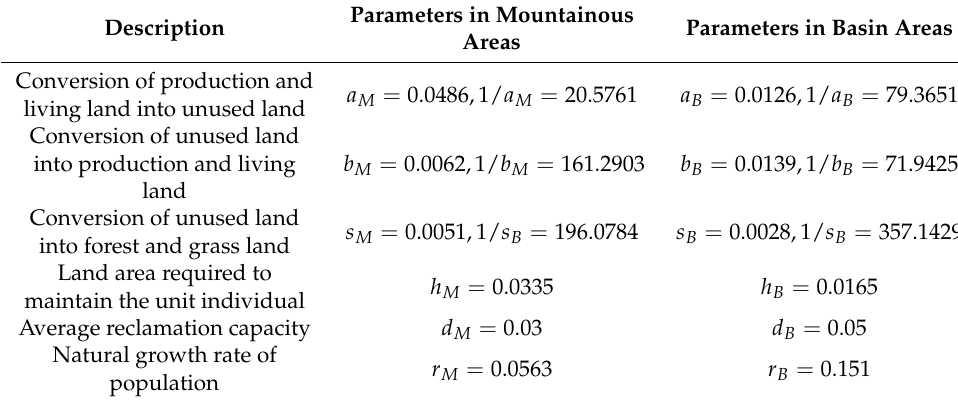
Table 2. Fitting parameters of human–land coupling dynamics model in mountainous areas and basin areas of Yuxi City. Parameters in Mountainous Parameters in Basin Areas Description Areas Conversion of production